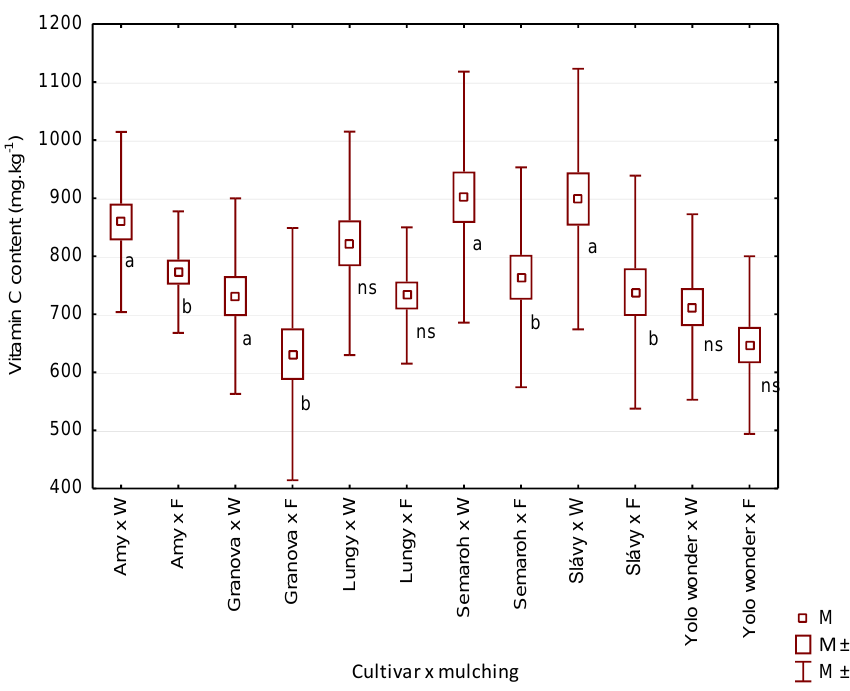
Figure 2. Vitamin C content (mg · kg − 1 ) in pepper cultivars under different treatments (W—Without mulching foil, M—mulching foil)—average value from all years and harvests. The result of the t-Student test between treatments is indicated in small letters next to the box (if there are differences, the higher average is lettered “a” and the lower average is lettered “b”; “ns” indicates no statistical